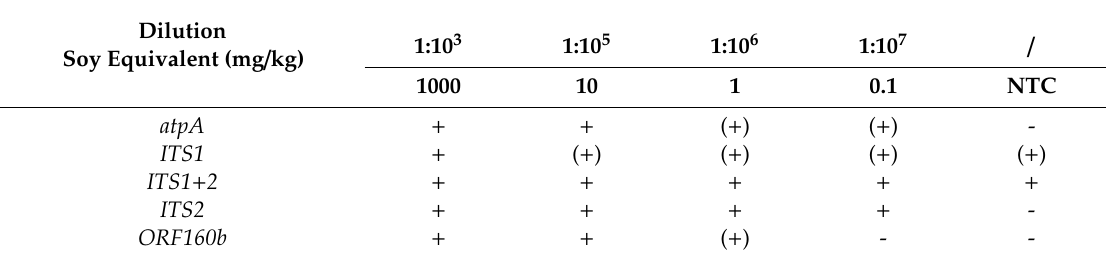
Table 4. Pre-assessment of sensitivity of the five LAMP assays based on serially diluted soybean DNA ( + : 2 / 2 replicates positive; ( + ): 1 / 2 replicates positive; -: 2 / 2 replicates negative).